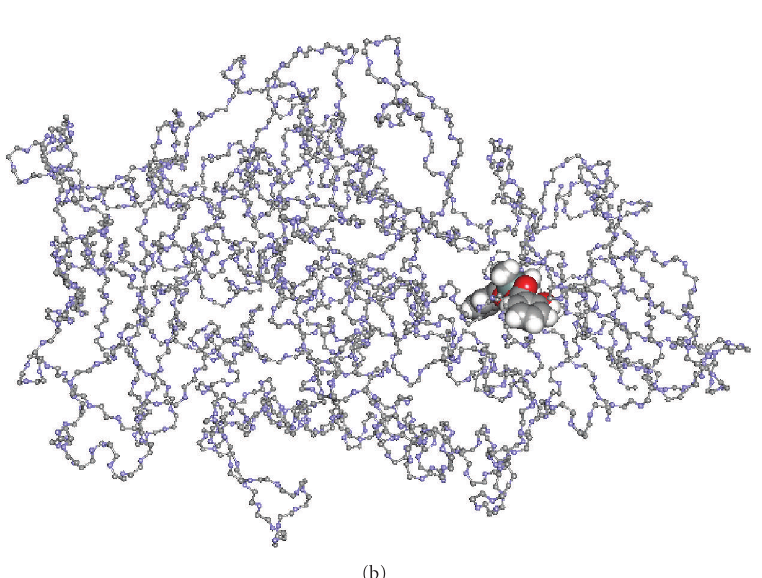
Figure 3: Binding sites of inhibitor 1 toward LOX in ESI and EI,